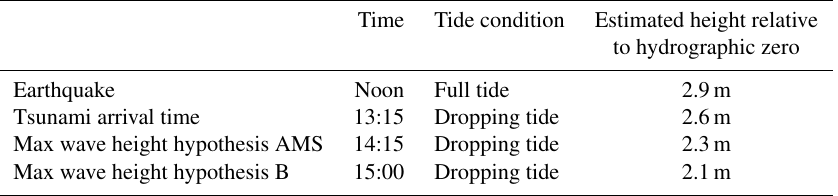
Table 5. Tide levels at the time of the earthquake and tsunami arrival. Time Tide condition Estimated height relative to hydrographic zero Earthquake Noon Full tide 2.9m Tsunami arrival time 13:15 Dropping tide 2.6m Max wave height hypothesis AMS 14:15 Dropping tide 2.3m Max wave height hypothesis B 15:00 Dropping tide